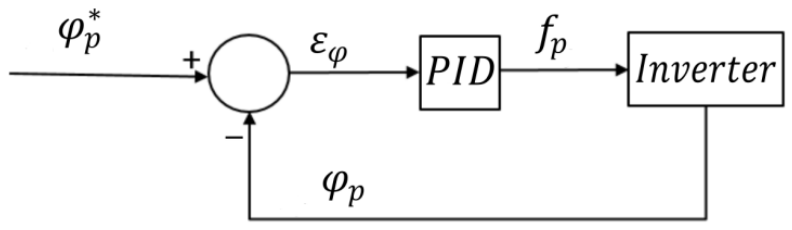
Figure 5. The control loop of the primary system.